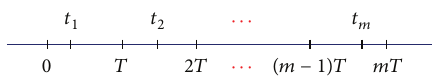
Figure 1: The distribution diagram of impulsive occurrences in periodically impulsive control systems with impulse time